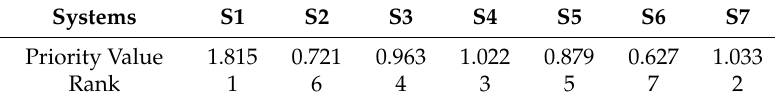
Table 3. Priority value and rank of systems with super-efficiency DEA (SE-DEA).